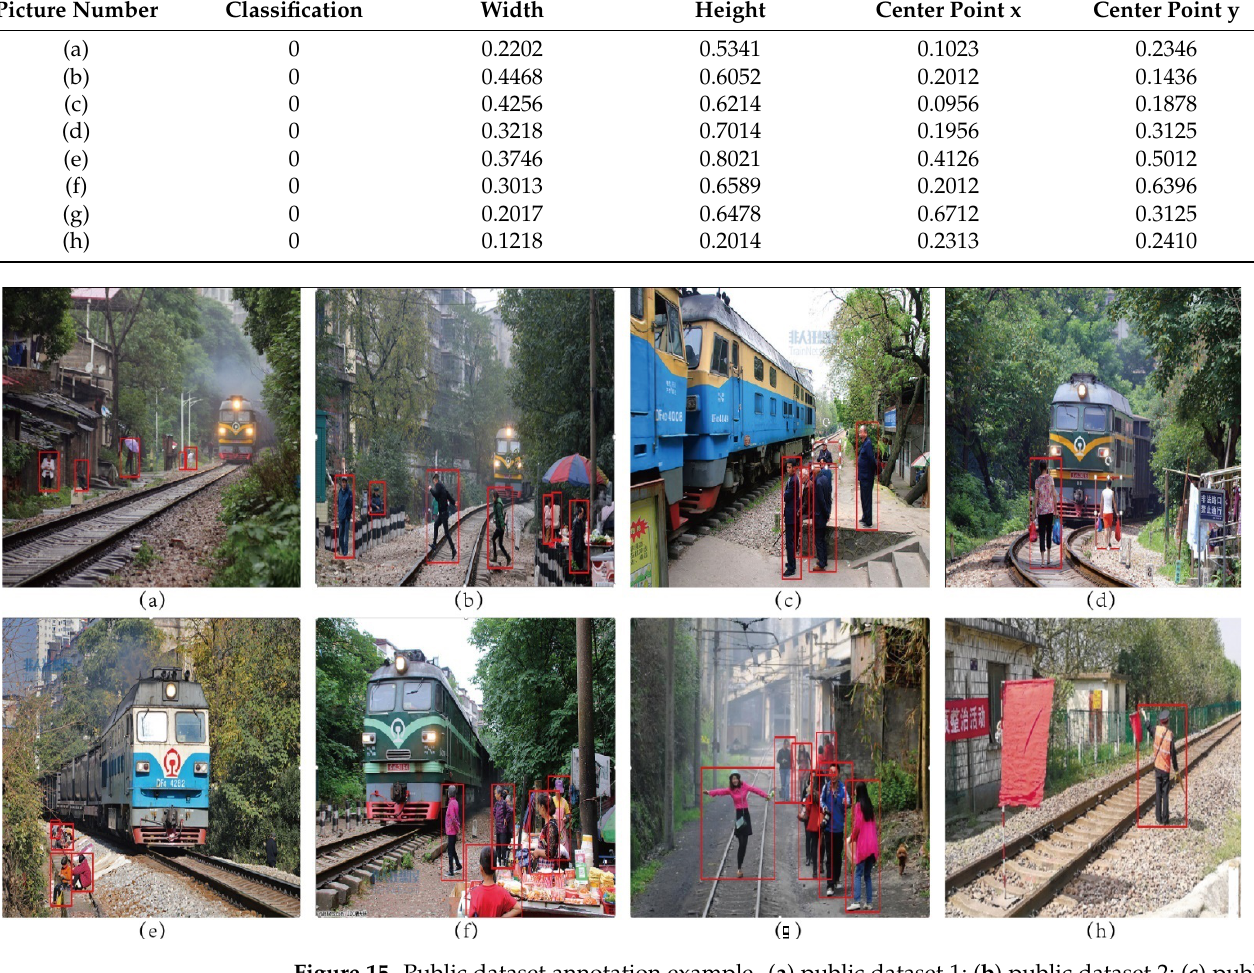
Figure 15. Public dataset annotation example. ( a ) public dataset 1; ( b ) public dataset 2; ( c ) public